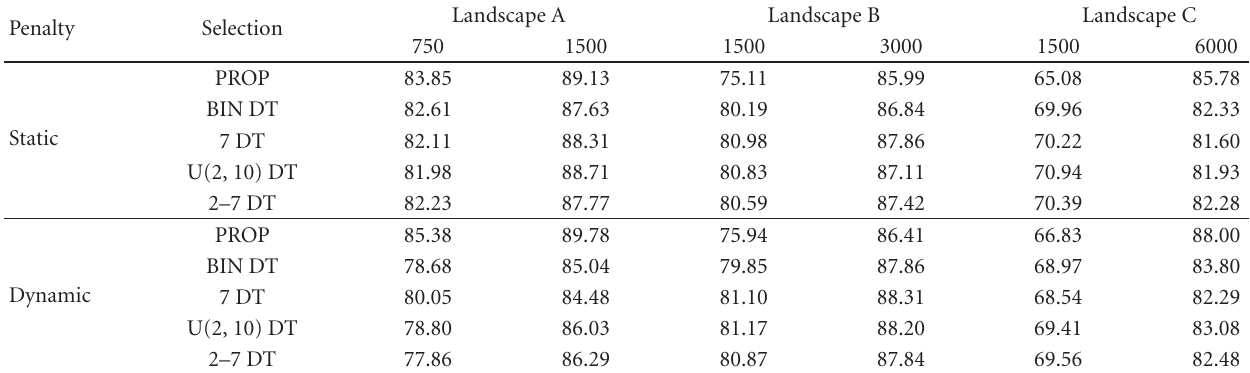
Table 4: Average solutions for landscapes A, B, and C. We present the average solution in terms of percent of trivial upper bound (TUB), for each selection/penalty combination. The secondary column heading represents the maximum number of generations. PROP: Proportional selection; BIN DT: Binary, deterministic tournament; 7 DT: A deterministic tournament with 7 competitors; U(2, 10) DT: A deterministic tournament with the number of competitors sampled from a uniform distribution on the range (2, 10); 2–7 DT: A deterministic tournament where the number of competitors increases from 2 to 7 throughout the course of the search.